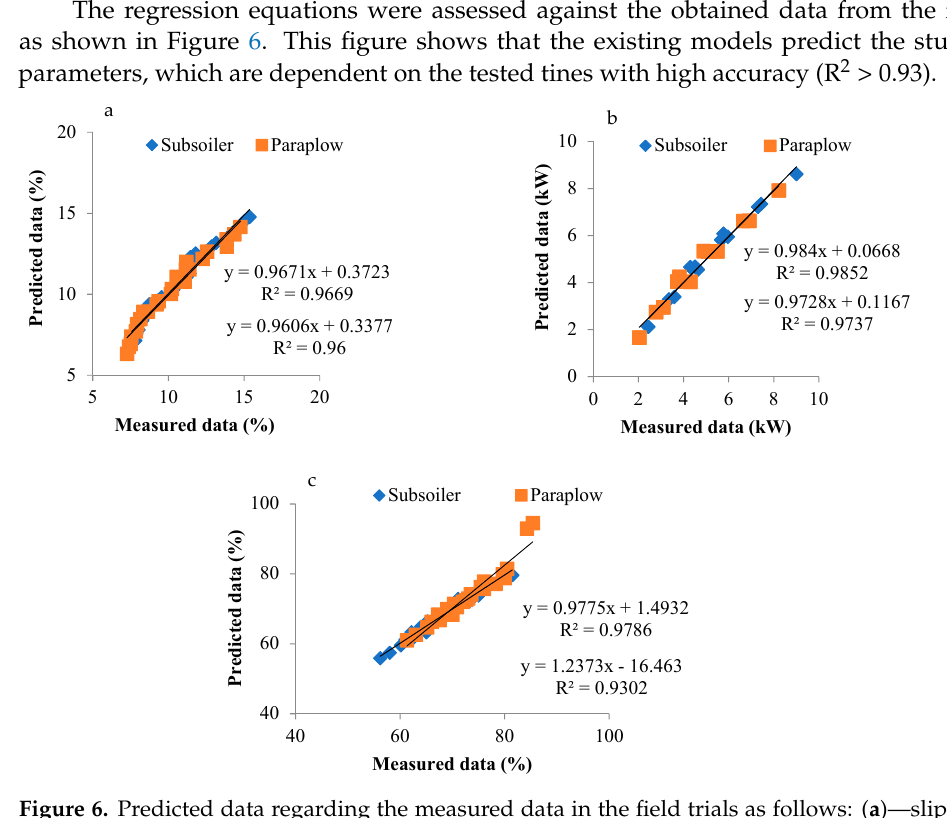
Figure 6. Predicted data regarding the measured data in the field trials as follows: ( a )—slippage, ( b )—drawbar power, ( c )—traction efficiency. The highest correlation (R 2 ) was related to the drawbar power prediction model of the subsoiler, at 0.9852, and the lowest correlation was related to the traction efficiency